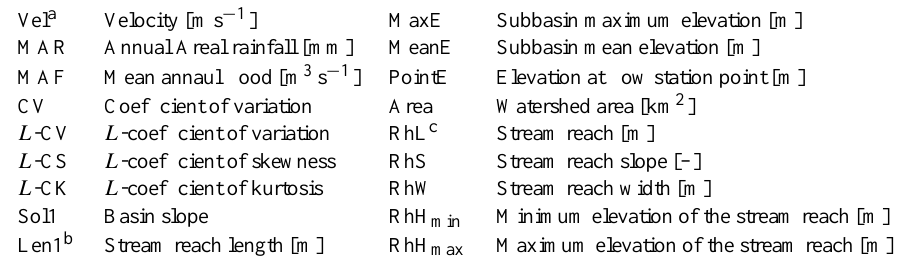
Table 1. Physical and flow catchment characteristics considered paramount in influencing the magnitude of peak flows.